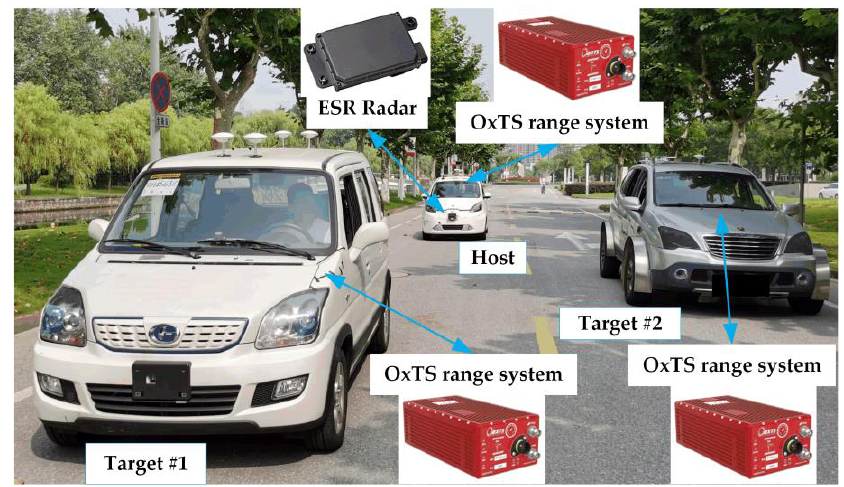
Figure 3. Configuration of the host and target vehicle.